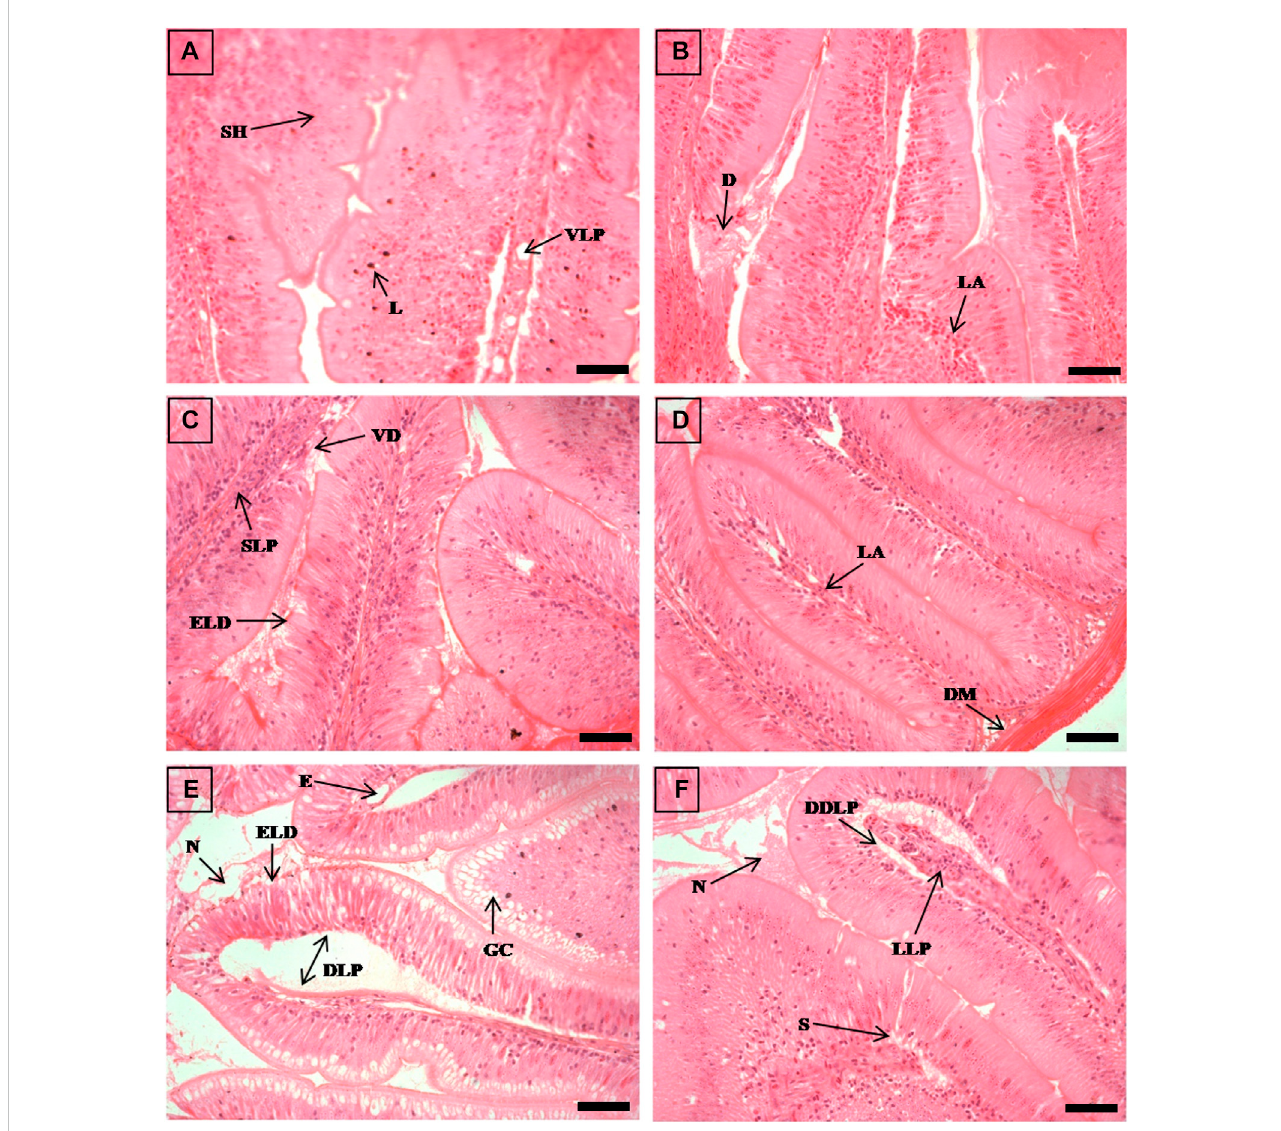
FIGURE 1 The histological sections (4 µm) of intestine tissues from EB-administered golden mahseer on 11th day (A, B) and 21st day (C – F) of EB-medication. The histologicalchangesinintestinetissuesof fi shesfedwithEBdoses (A) at250 μ g/kg fi sh/dayshowingvacuolatedlaminapropria(VLP),submucosalhyperplasia (SH), deeply stained lymphocytes (L); (B) at 500 μ g/kg fi sh/dayshowing degenerative changes in lamina propria and submucosa (D) , lymphocytes abundance (LA); (C) at50 μ g/kg fi sh/dayshowingswellingoflaminapropria(SLP),epitheliallayerdisintegration(ELD),vilidegeneration(VD); (D) at100 μ g/kg fi sh/day showing disarrangement of muscularis mucosa (DM), abundant lymphocytes in lamina propria (LA); (E) at 250 μ g/kg fi sh/day showing abundant goblet cells (GC),extensivelydilatedlaminapropria(DLP),epitheliallayerdisintegration(ELD),oedema (E) ,necroticdebriesinlumen(N); (F) at500 μ g/kg fi sh/dayshowing dilated and distended lamina propria (DDLP), splitting of submucosal layer (S), lymphocytes aggregation in lamina propria (LLP), necrotic debries in lumen (N). TheH&Estainedsectionsarevisualizedatmagni fi cationof×400underinvertedlightmicroscope(OlympusIX53,Canada).Thescalebarvaluedepictedinthe right bottom corner (A – F) is 20